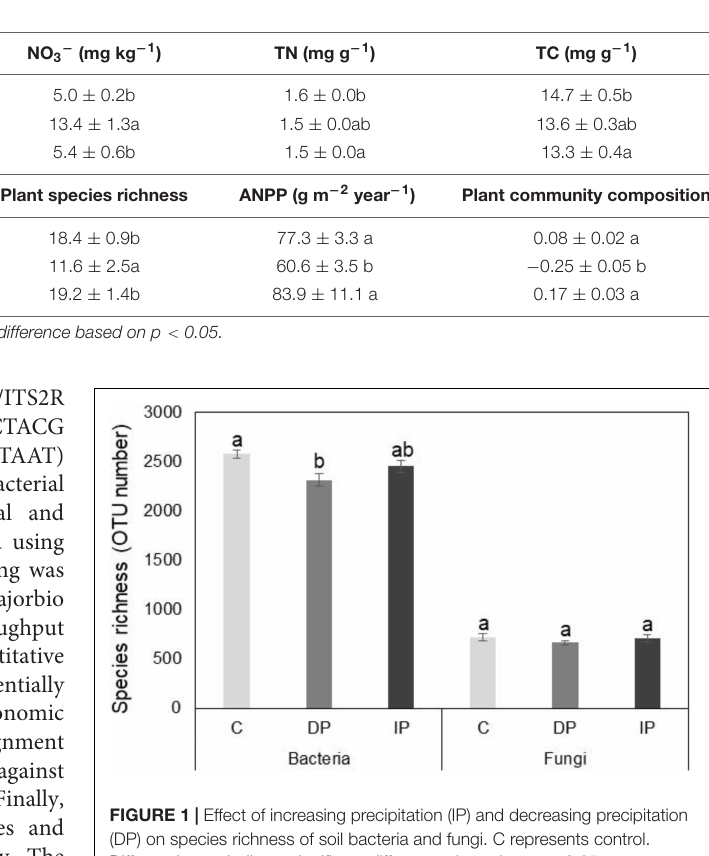
TABLE 1 | Results ( F -values) of one-way ANOVAs on effects of decreasing precipitation (DP) and increasing precipitation (IP) on soil temperature (ST, ◦ C), soil moisture (SM, %), NH